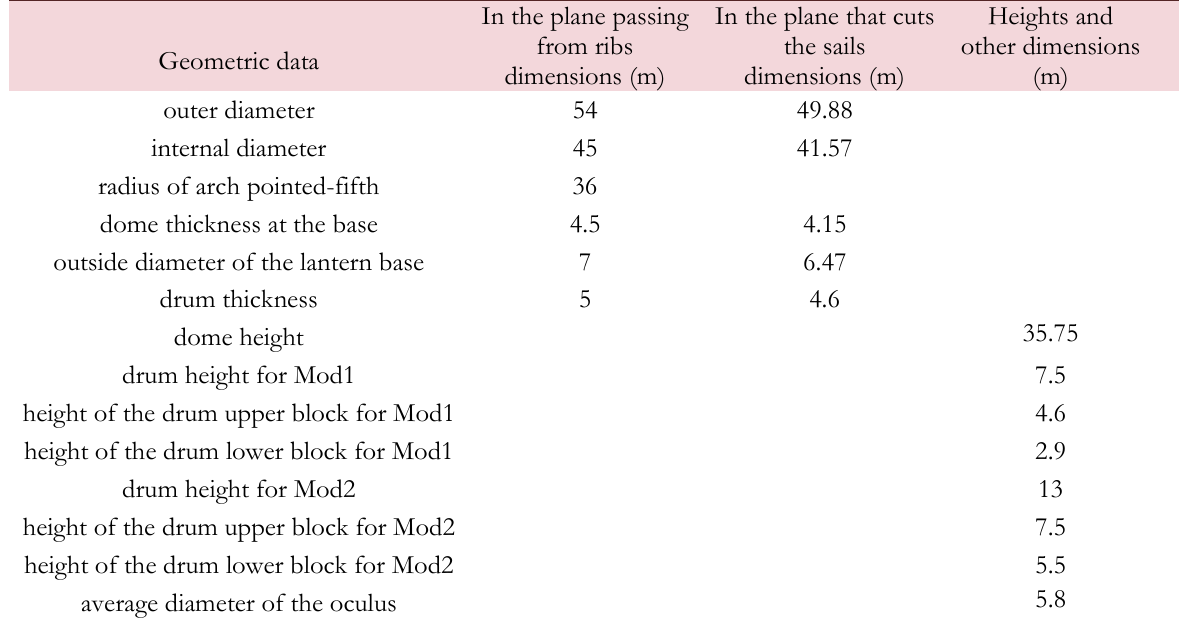
Table 4: Geometric data of S. Maria del Fiore